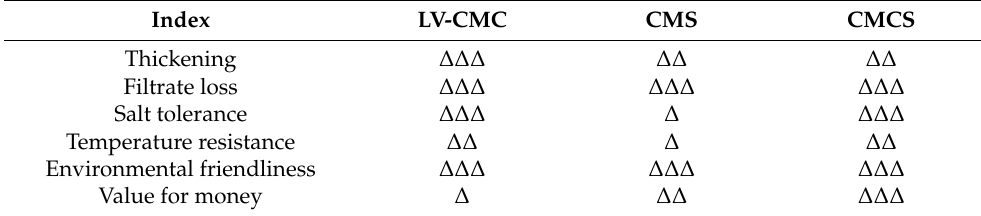
Table 3. Comparison results of LV-CMC, CMS, and